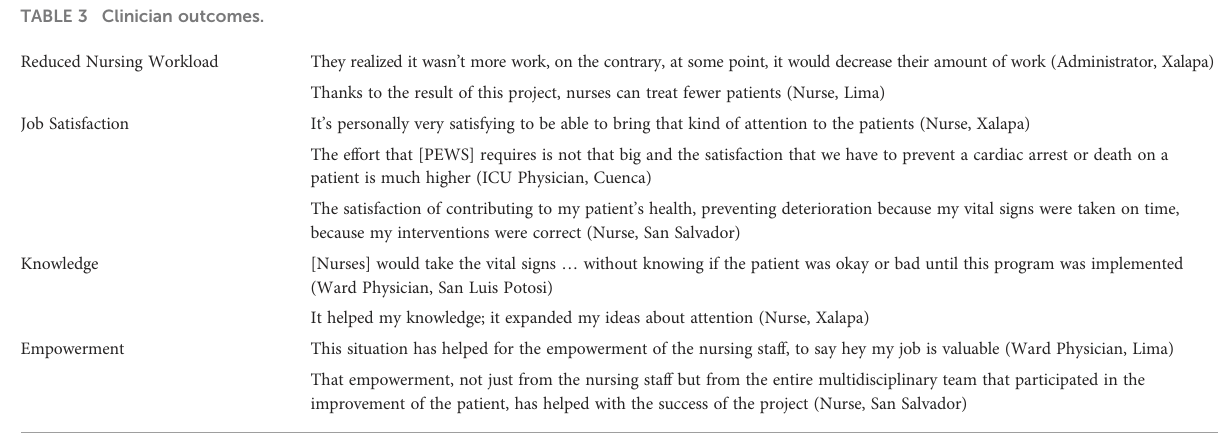
TABLE 3 Clinician outcomes. Reduced Nursing Workload